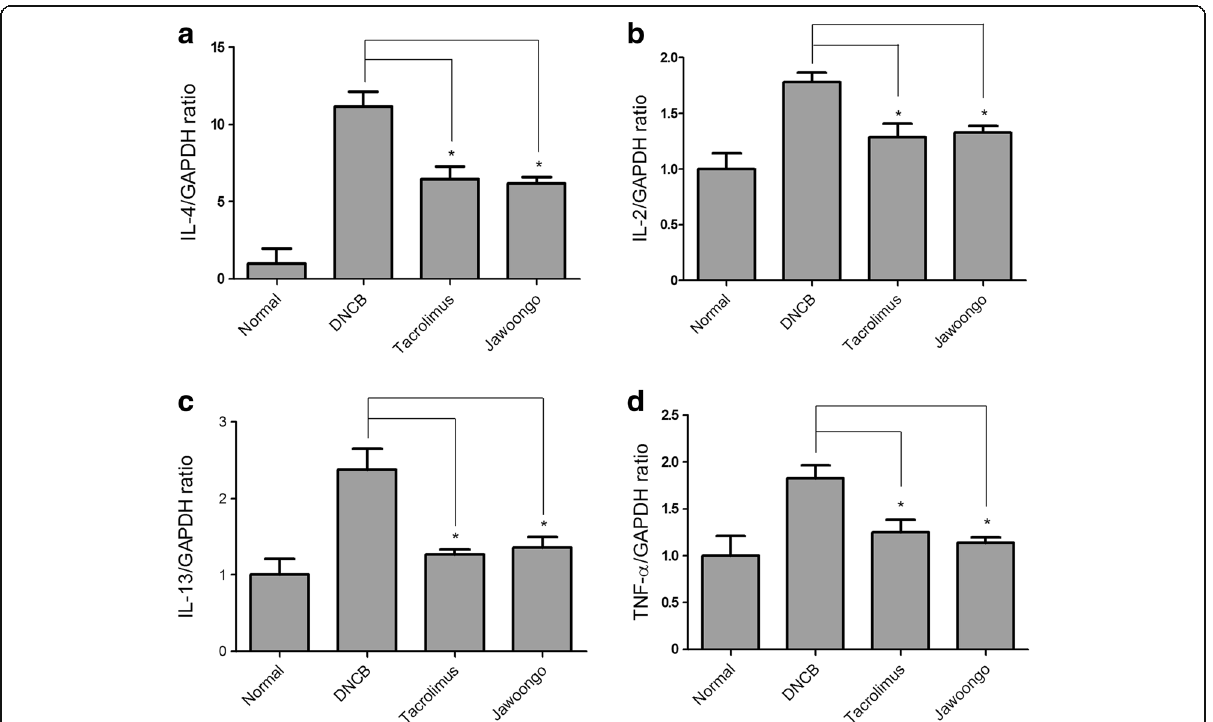
Fig. 5 Effects of Jawoongo on cytokine mRNA expression in mouse skin tissue. IL-2, IL-4, IL-13 and TNF- α mRNA expression was measured by RT-PCR, shown in ( a ), ( b ), ( c ), and ( d ), respectively, in mouse skin tissue. The data were presented as mean ± SEMs ( n = 8 mice/group). * P < 0.05, ** P < 0.01 and *** P < 0.001 as compared to DNCB-stimulated group,